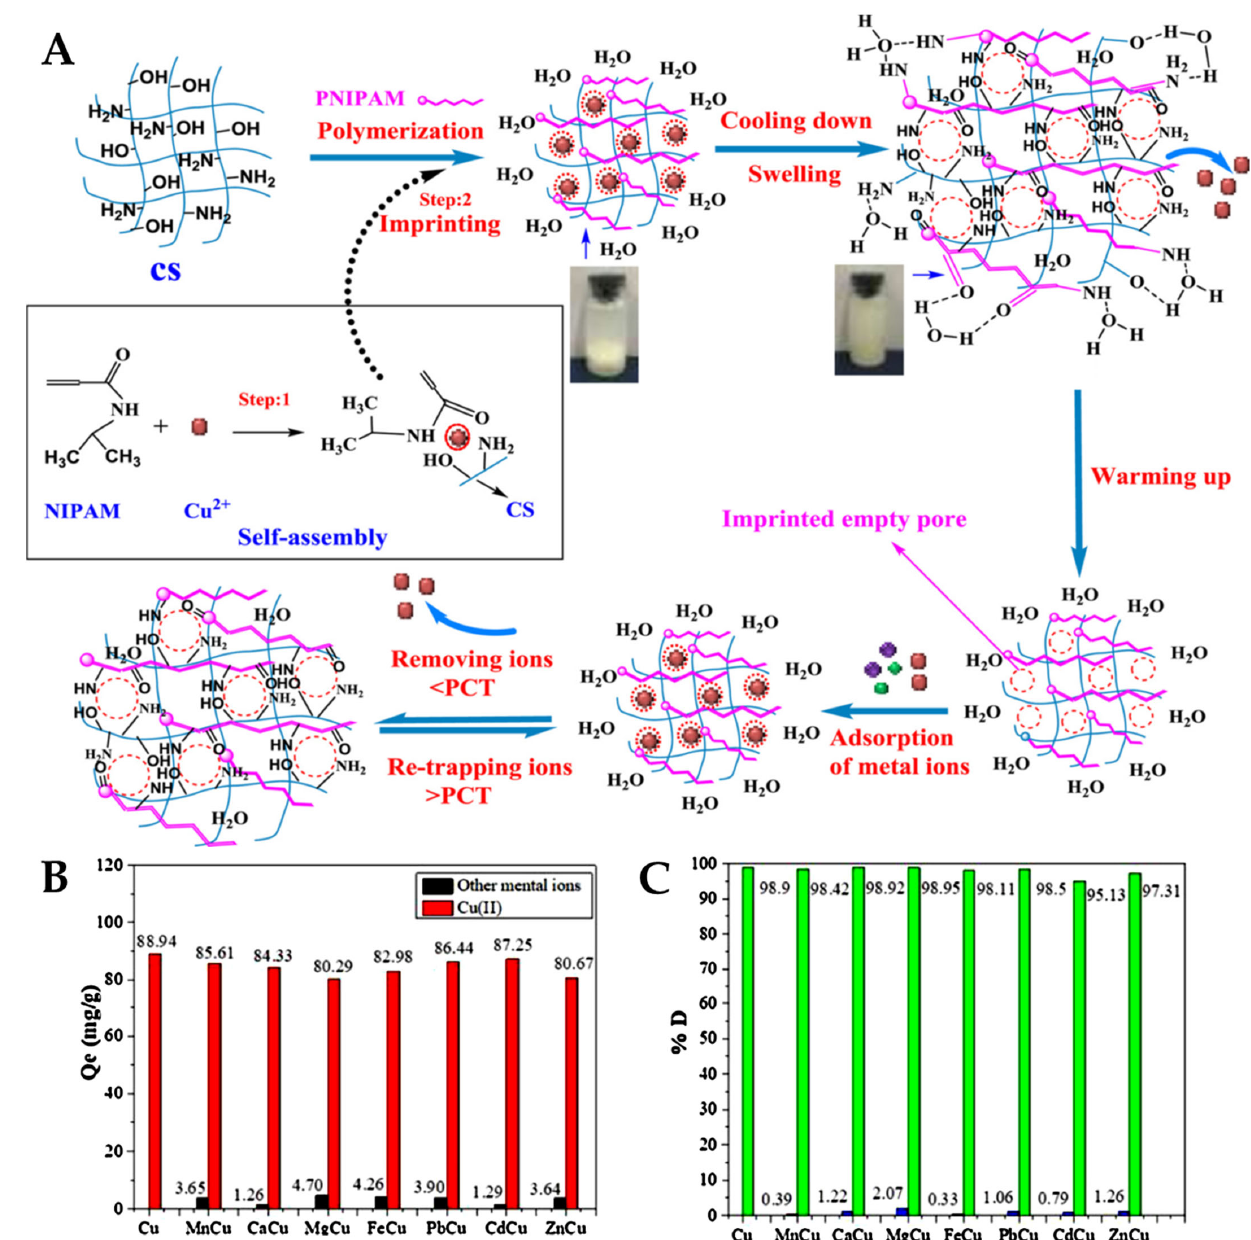
Figure 7. Representation with the preparation, and HMIs adsorption and desorption by thermo ‐ sensitive Cu(II) ‐ imprinted PNIPAAm ‐ CS composites ( A ). Effect of interfering HMIs on the equi ‐ librium adsorption capacity ( q e , mg/g) ( B ) and desorption percentage (D, %) ( C ) of Cu(II) ‐ imprinted PNIPAAm ‐ CS composites. (Adapted with permission from Ref. [64]. Copyright 2020 Elsevier). The sorbent exhibited a phase change temperature (PCT) at 35.31 °C in the heating cycle, and at 26.27 °C in the cooling cycle. After synthesis, the template Cu(II) ions were In another work, Qin et al., developed Cu(II)-imprinted MMT/CS gel beads as promis- removed from the sorbent by decreasing the temperature below the PCT, followed by ing sorbents for the selective removal of Cu(II) from multi-HMIs solutions [65]. The washing with cold water. The PNIPAAm chains elongated at temperatures below PCT, thus disrupting the interactions between Cu(II) ions and the functional groups of the sorbent. By subsequently increasing the temperature above PCT, the sorbent shrunk again to regain the sorption properties toward Cu(II) ions. The sorbent attained a maxi ‐ mum sorption capacity of 105.49 mg Cu(II)/g at 318 K, pH 6, and 0.5 g/L sorbent dose.